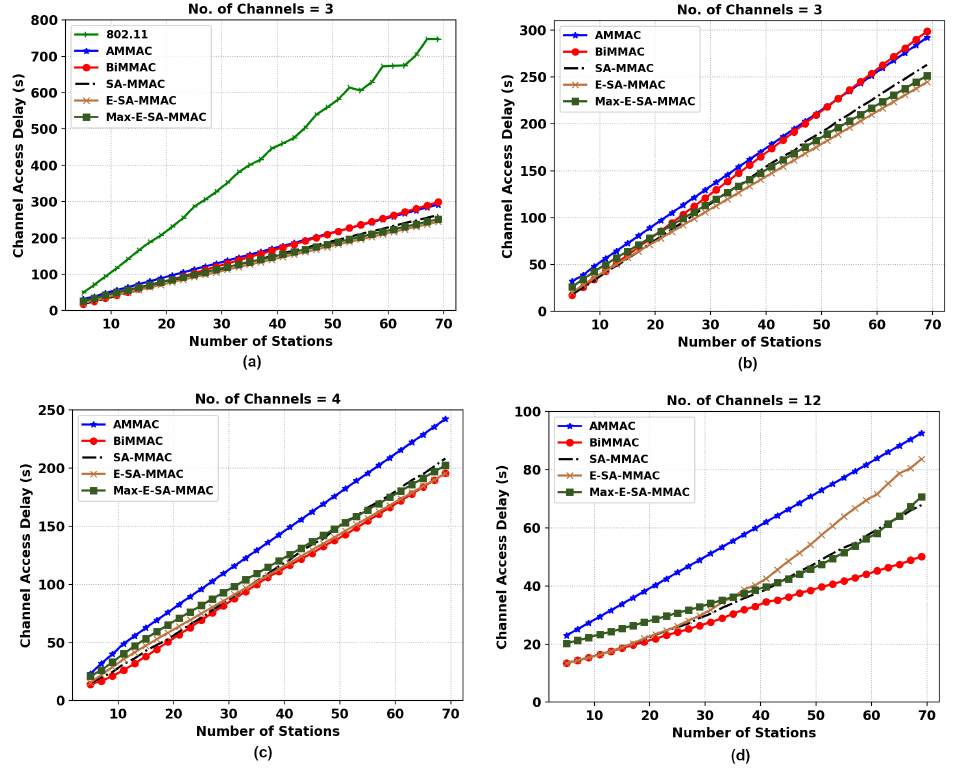
Figure 8. Channel access delay comparison of the two MMAC protocols, E-SA-MMAC, and Max-E- SA-MMAC, versus others. ( a ) Three channels with IEEE 802.11, ( b ) three channels, ( c ) four channels, and ( d ) twelve